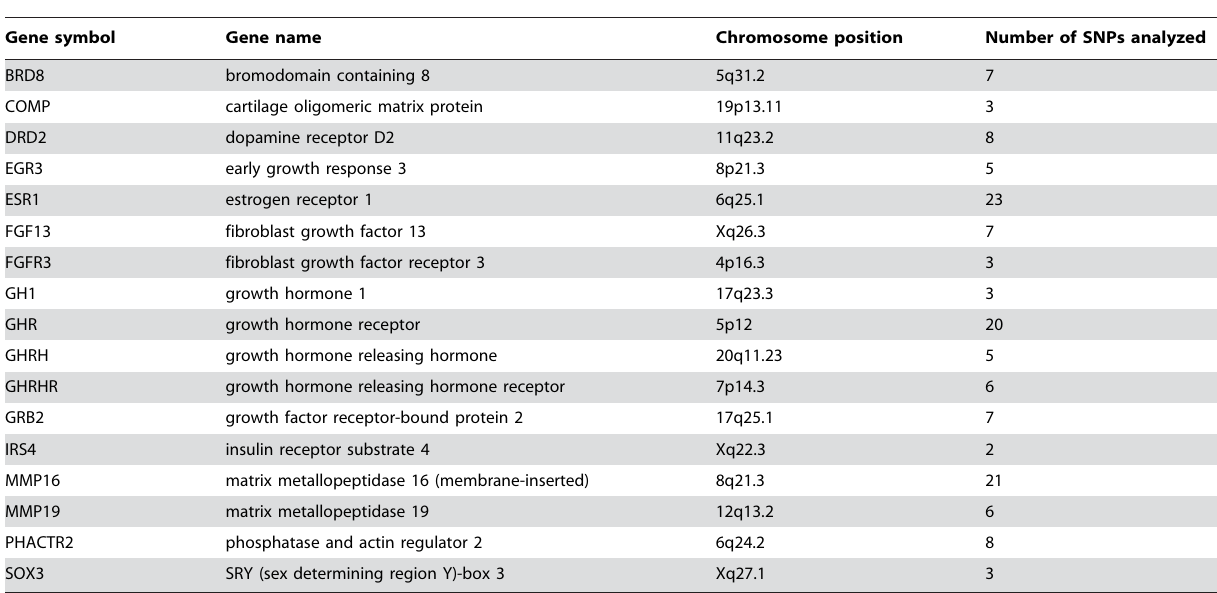
Table 1. Genes and number of SNPs analyzed for association with body height